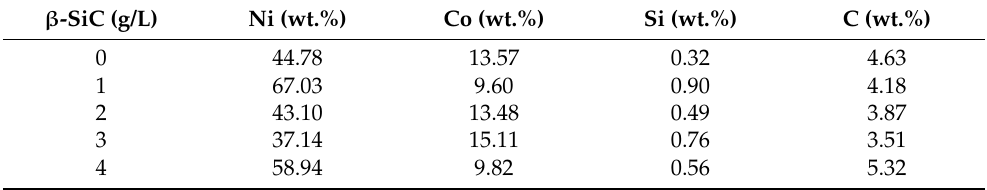
Table 3. Mass fraction of the elements in the coating with different nanoparticle concentrations. β -SiC (g/L) Ni (wt.%) Co (wt.%) Si (wt.%) C